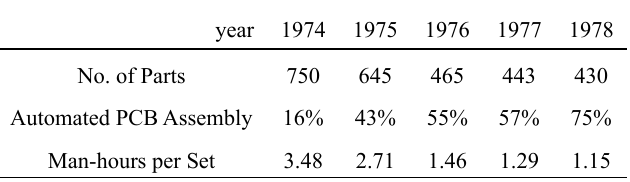
Table 2. Productivity of Japanese TV Industry